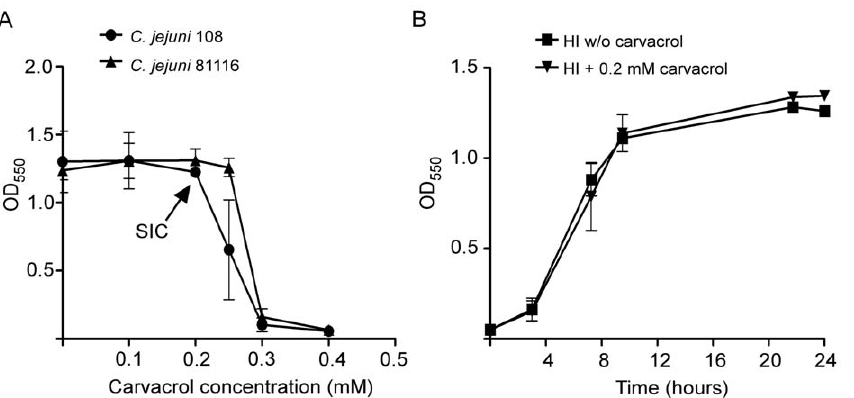
Figure 1. Effect of carvacrol on C.jejuni growth. (A) Growth of C. jejuni strains 108 and 81116 in HI supplemented with increasing concentrations of carvacrol as determined after 16 h of incubation. The maximum sub-inhibitory concentration (SIC) is indicated by an arrow. (B) Growth kinetics of C. jejuni strain 108 with or without carvacrol at SIC monitored during a 24 h-period. Results are mean values 6 standard error of three independent experiments.